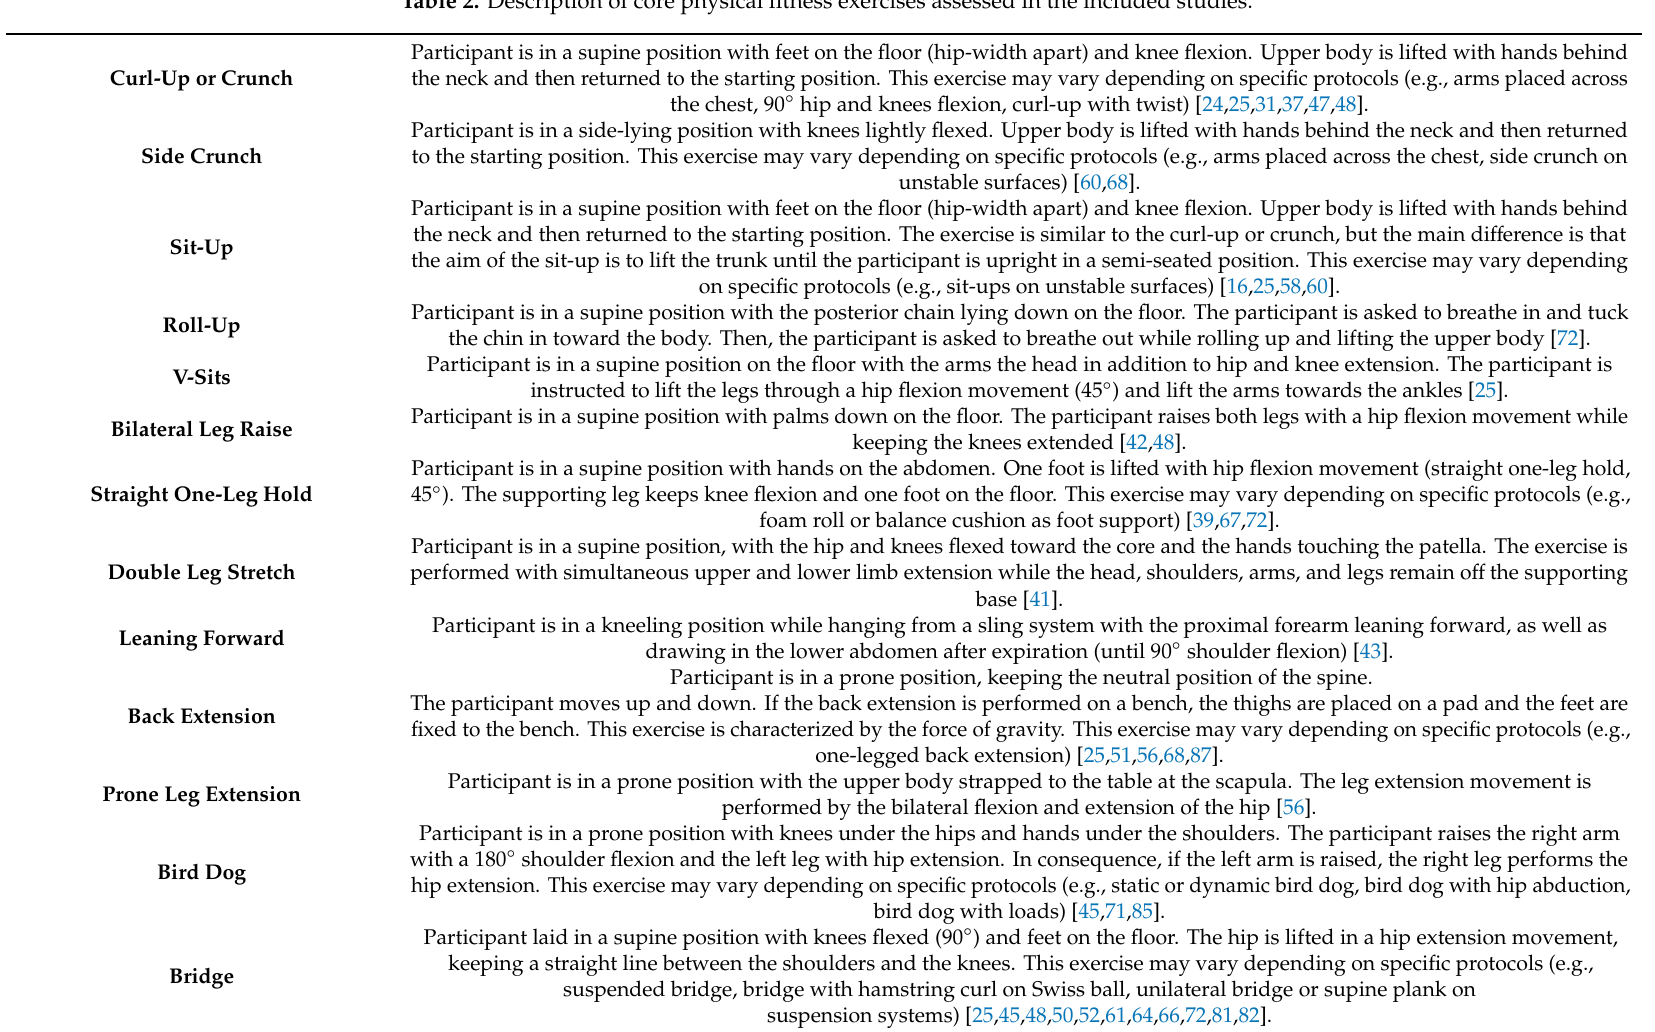
Table 2. Description of core physical fitness exercises assessed in the included